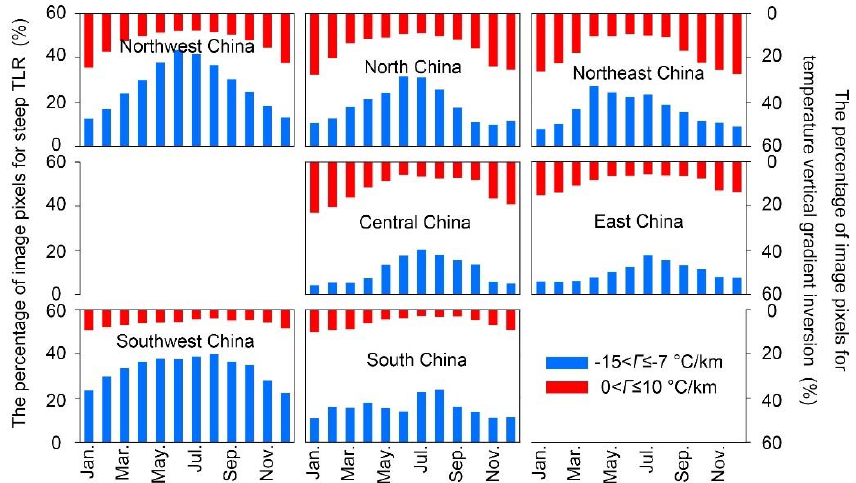
Figure 5. Bar chart of the percentage of image pixels for the steep TLR (blue) and the temperature vertical gradient inversion (red) in each region. The primary and secondary Y-axis represent the percentages for the steep TLR and the temperature vertical gradient inversion, respectively.